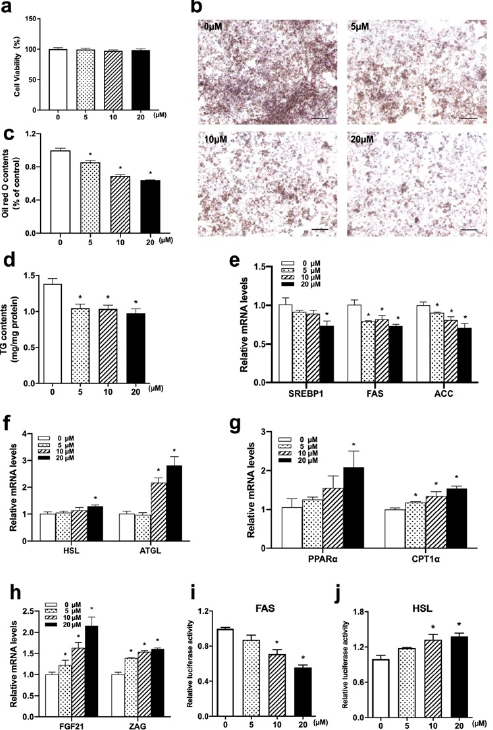
Figure 5. Nuci suppressed lipid accumulation by reducing lipogenesis and promoting lipolysis in HepG2 hepatocyte. Cell viability after treatment of 0~20 µ M Nuci were determined by CCK-8 ( a ). Cells were stained by Oil red O and photographed at 100 × magnification ( b ) and Oil red O dye was extracted and detected ( c ). Intracellular TG contents ( d ) were determined by a commercial kit following the manufacturer’s instructions. The mRNA expressions of lipogenesis-related genes SREBP1, FAS, and ACC ( e ), lipolysis-related genes HSL and ATGL ( f ), fatty acid oxidation-related genes PPAR α and CPT1 ( g ), and adipokines FGF21 and ZAG ( h ) were determined by RT-qPCR. Cells were transiently transfected with hFAS625-Luc and hHSL750-Luc plasmids and the luciferase activities of FAS ( i ) and HSL ( j ) were measured. The firefly luciferase activities were adjusted by the renilla luciferase. Data were presented with mean ± SE from three independent experiments, each concentration was repeated for 9~12 wells. * p < 0.05 vs. the control group (0 µ